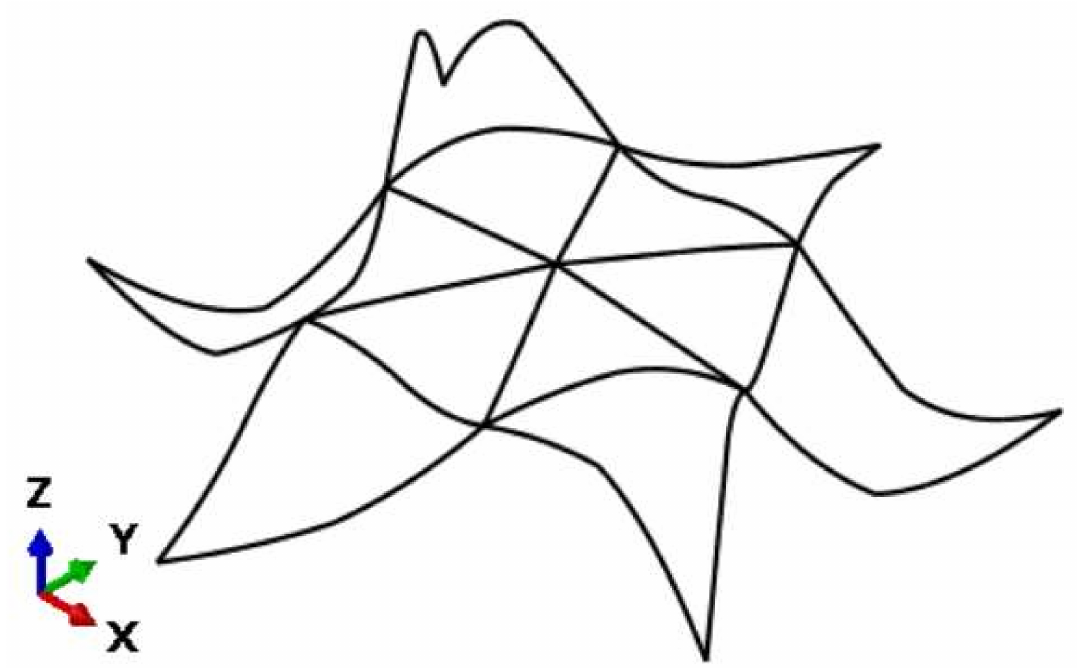
Figure 11. Dome 2—imaginary part of the third nonlinear eigenvector (values multiplied by 1500). With the exception of the first incremental step of the continuation procedure, in a typical incremental step, one or two iterations are required to achieve a convergent solution to NEP for the given value of the continuation parameter κ . However, in the first incremental step, a number of iterations are likely to be of the order 10 when the Jarlebring method is used. This fact suggests that the proposed initial approximation of the solution is not optimal. The second choice of the above-mentioned initial approximation of the NEP’s solution is assumed as the natural frequency and mode of vibration of dome 1, i.e.,